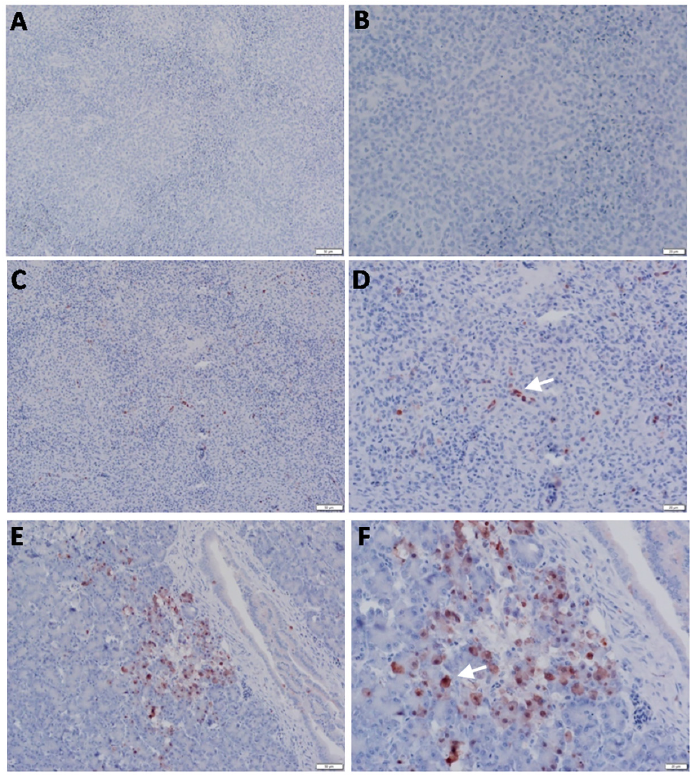
Fig 5. Detection of viral NP antigen in spleen and pancreas by IHC. (A and B ) Spleen of non-infected birds (X = 50 and 20 μ m, respectively). (C ) Lymphocytes in spleen of infected birds (X = 50 μ m). ( D ) Lymphocytes and mononuclear cells in spleen of infected birds (arrow) (X = 20 μ m). ( E and F) Acinar epithelium of pancreas of infected birds (X = 50 and 20 μ m, respectively).